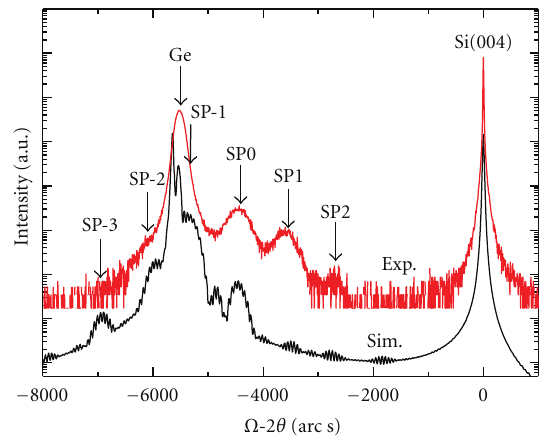
Figure 2: XRD Ω -2 θ profiles of Ge epilayer on LT-Ge layer ans SLSs. Figure 3: A typical AFM image for Ge surface.